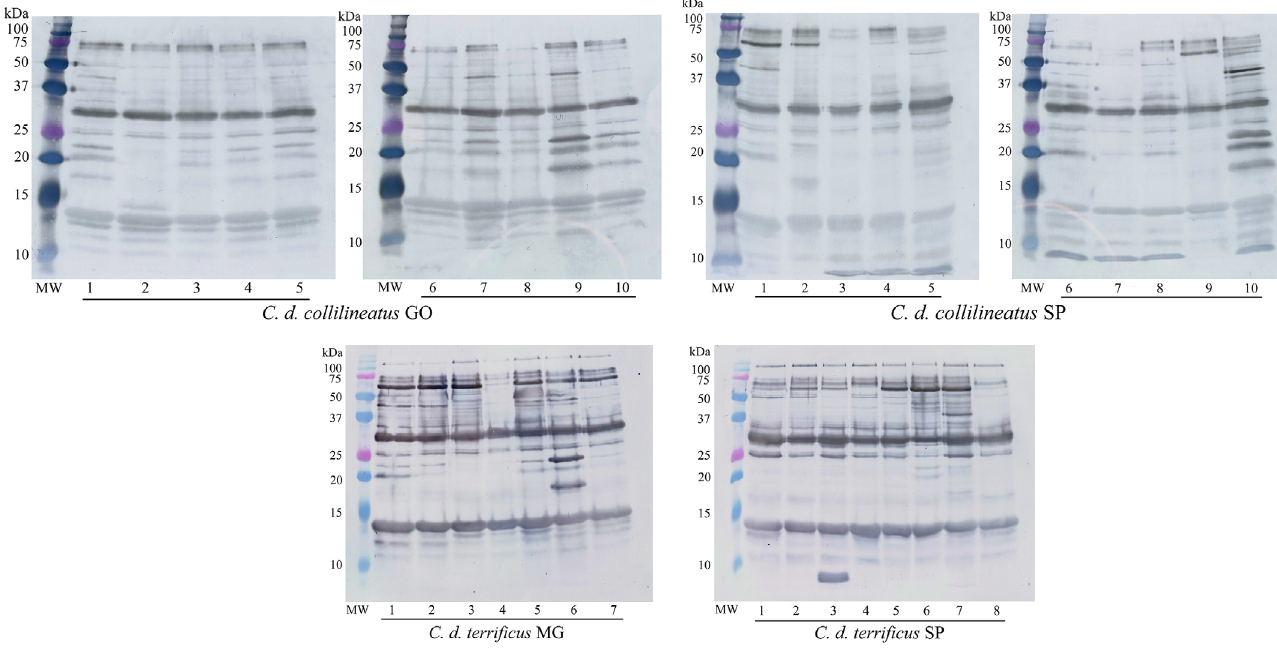
Figure 10. Immunorecognition profile obtained of individual C. d. collilineatus and C. d. terrificus venom by anticrotalic antivenom produced by Butantan Institute by Western blotting. Venom proteins (20 μg) were subjected to SDS-PAGE 15% under reducing conditions and electrotransferred to a PVDF membrane. Membrane was sequentially incubated with anti-bothropic antivenom and peroxidase-conjugated anti-horse IgG. The reaction was developed using DAB and O . MW: molecular weight marker (Dual Color Precision Plus Protein Standards – BioRad); C. d. collilineatus GO: specimens from Goiás state; C. d. collilineatus H 2 2 SP: specimens from São Paulo state; C. d. terrificus MG: specimens from Minas Gerais state; C. d. terrificus SP: specimens from São Paulo